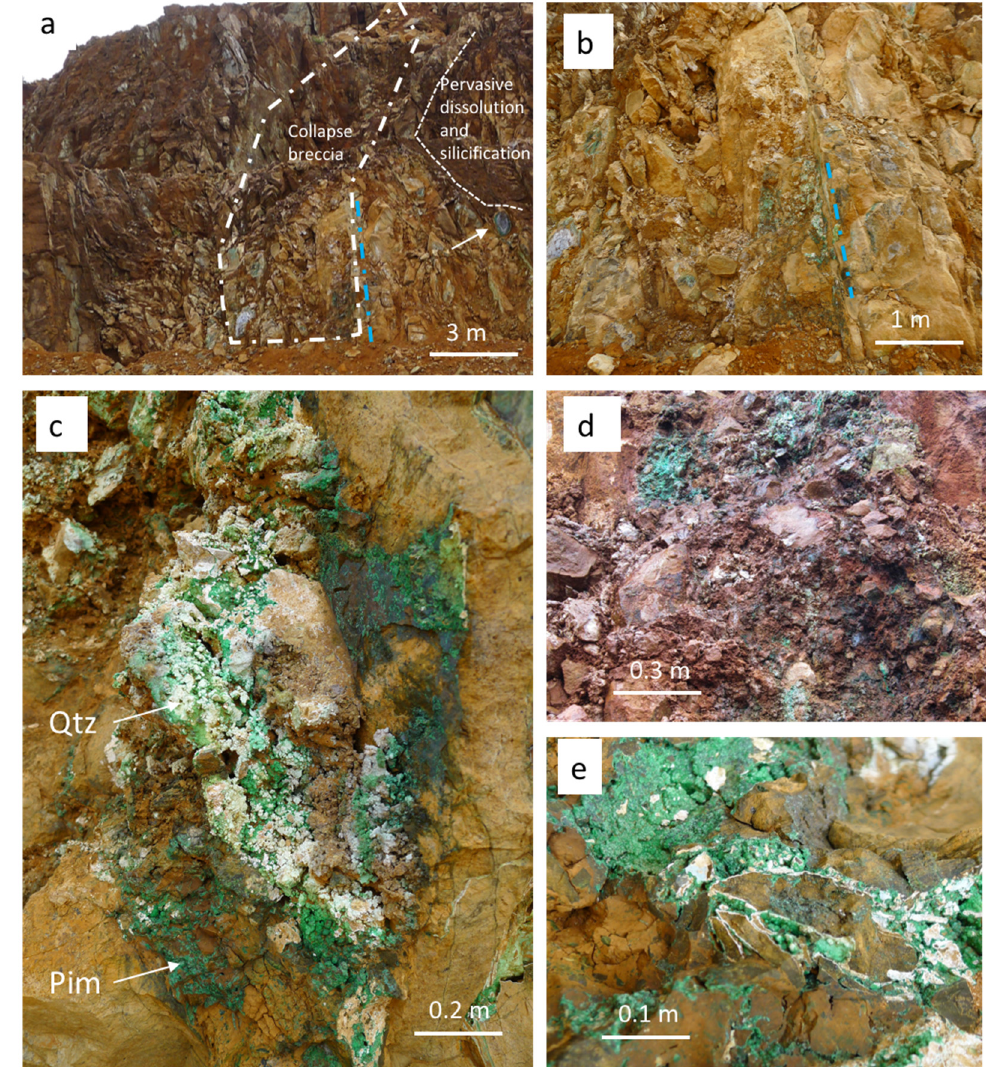
Figure 3. Collapse breccia (indicated by a white dashed line) in the open pit Cagou (former “207”) from the Koniambo mining site. ( a , b ) Photographs were taken in the upper part of the open pit showing the penetration of the dissolution pipes, which are accompanied by pervasive silicification (dashed line) and quartz fracture infillings. The white arrow indicates a target like ore type II in ( a ). In ( a , b ), the blue dashed lines indicate fractures filled with blueish kerolite and red quartz (ore Type I), as described in [24]. ( c ) Cemented breccia by Ni-silicate (pimelite) and quartz. ( d , e ) Details of the cement. The arrows indicate the location of target-like ores (without quartz), as described in [23]. Qtz: quar tz , Pim: pimelite.